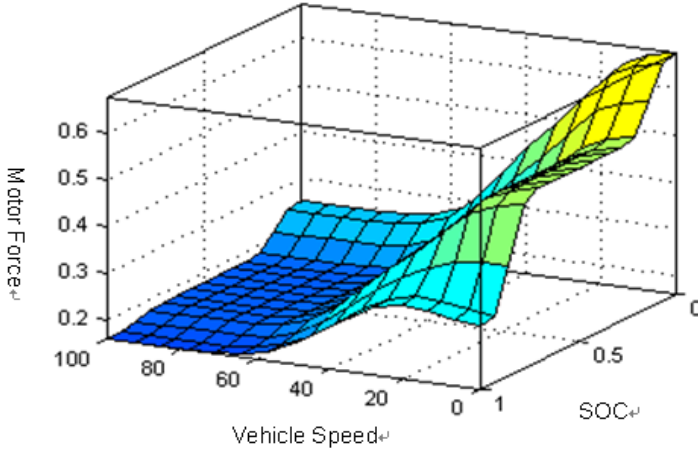
Figure 11. Relationships between vehicle speed, battery SOC and motor force.